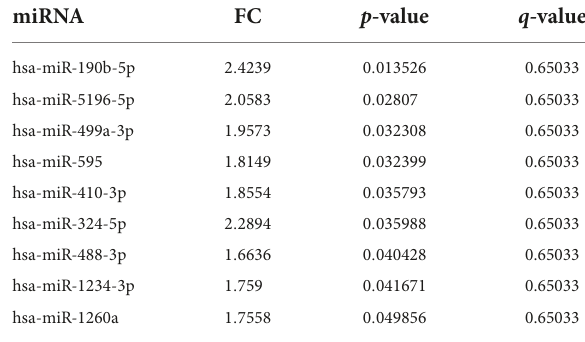
TABLE 2 miRNAs differentially expressed comparing non-DCI vs.